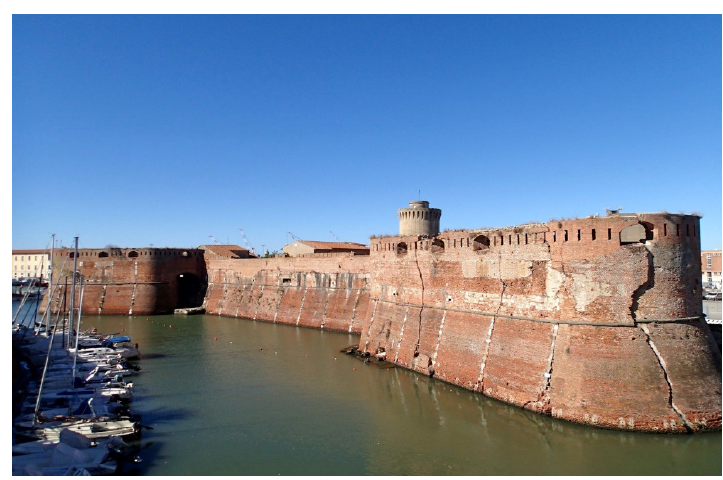
Figure 1. Fortezza Vecchia, Livorno, Tuscany (Italy). Evident structural defects can be noted on the walls of the ancient fortress (credits to Giacomo